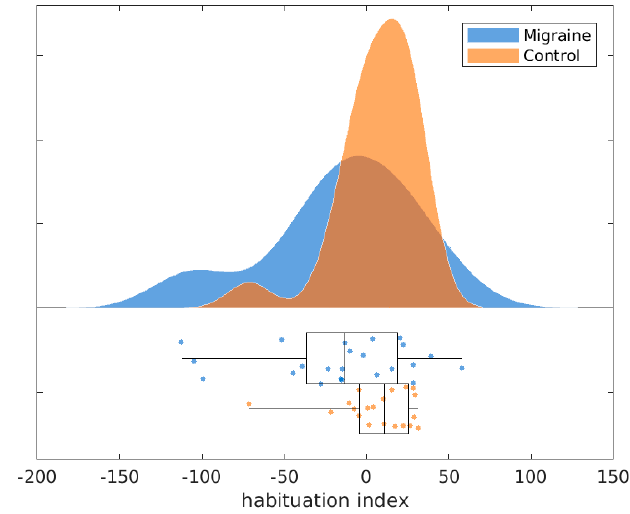
Figure 2. Habituation indices for migraine patients and healthy controls.